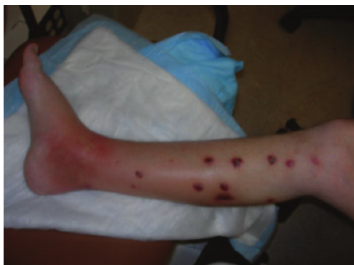
Figure 1: Clinical picture shows swelling and erythema over the medial aspect of the right ankle. In addition nodular lesions on the lower leg are seen.